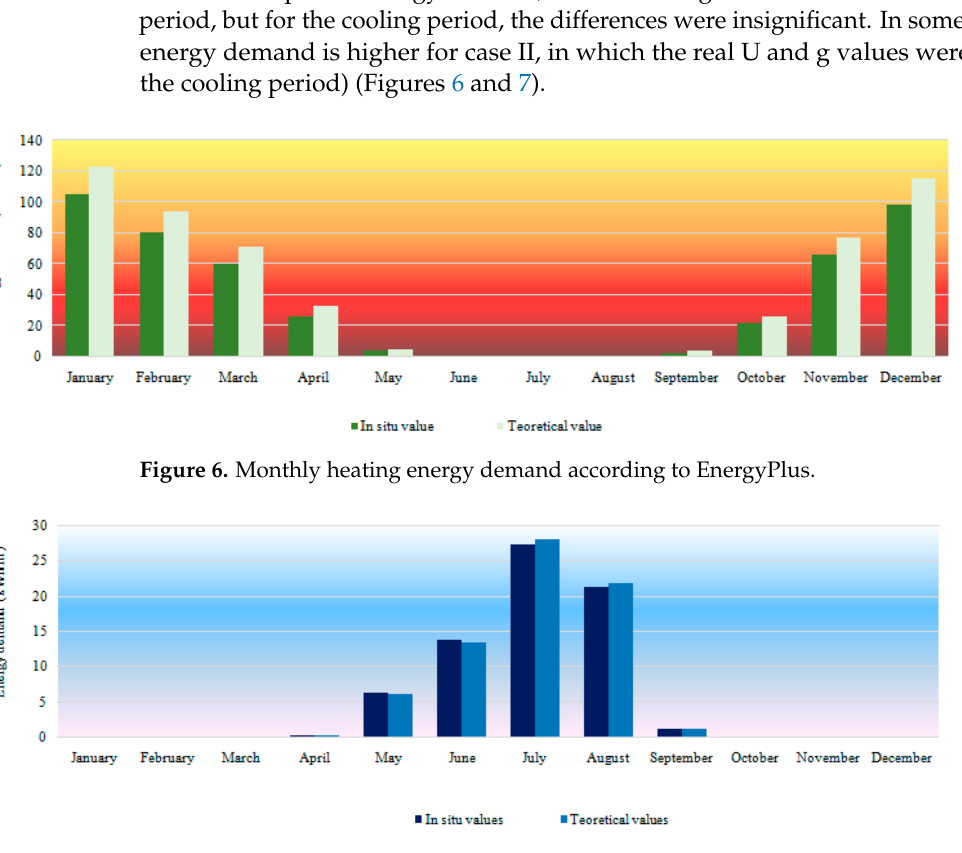
Table 7. Final results for the heating energy demand.